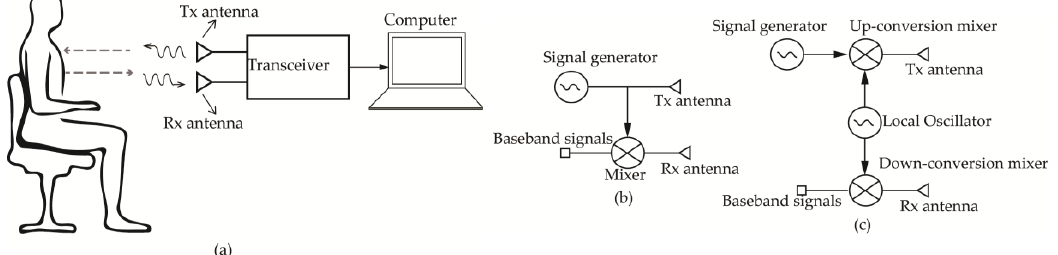
Figure 9. ( a ) Block diagram of vital signs Doppler. Basic transceiver architectures: ( b ) zero intermediate frequency (IF); (c) heterodyne.